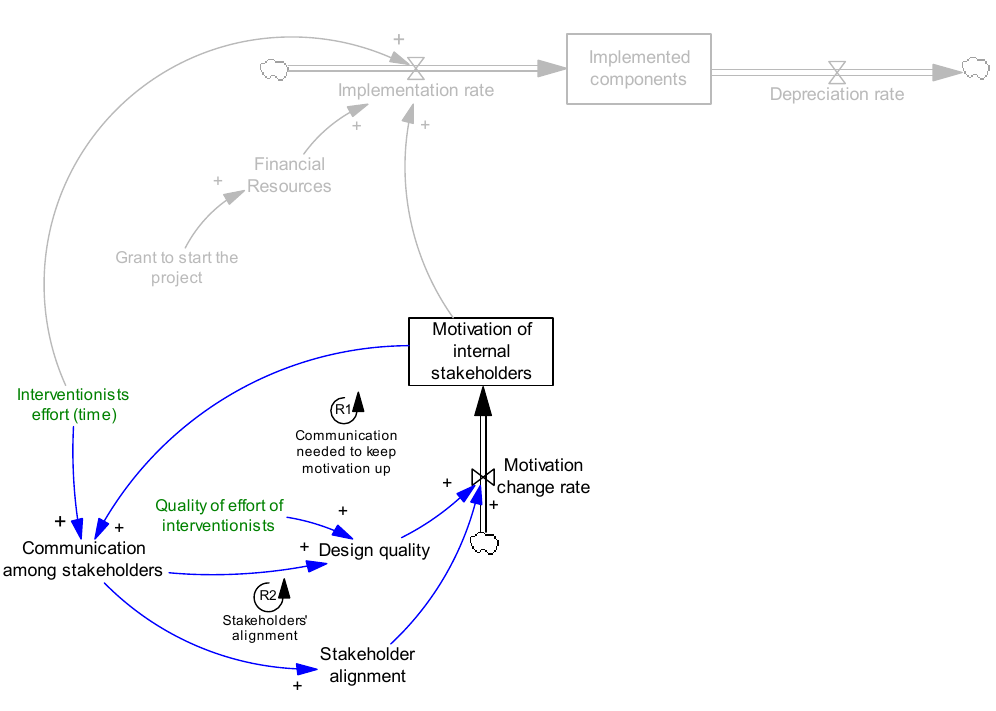
Figure 4. Effect of communication on stakeholder alignment.